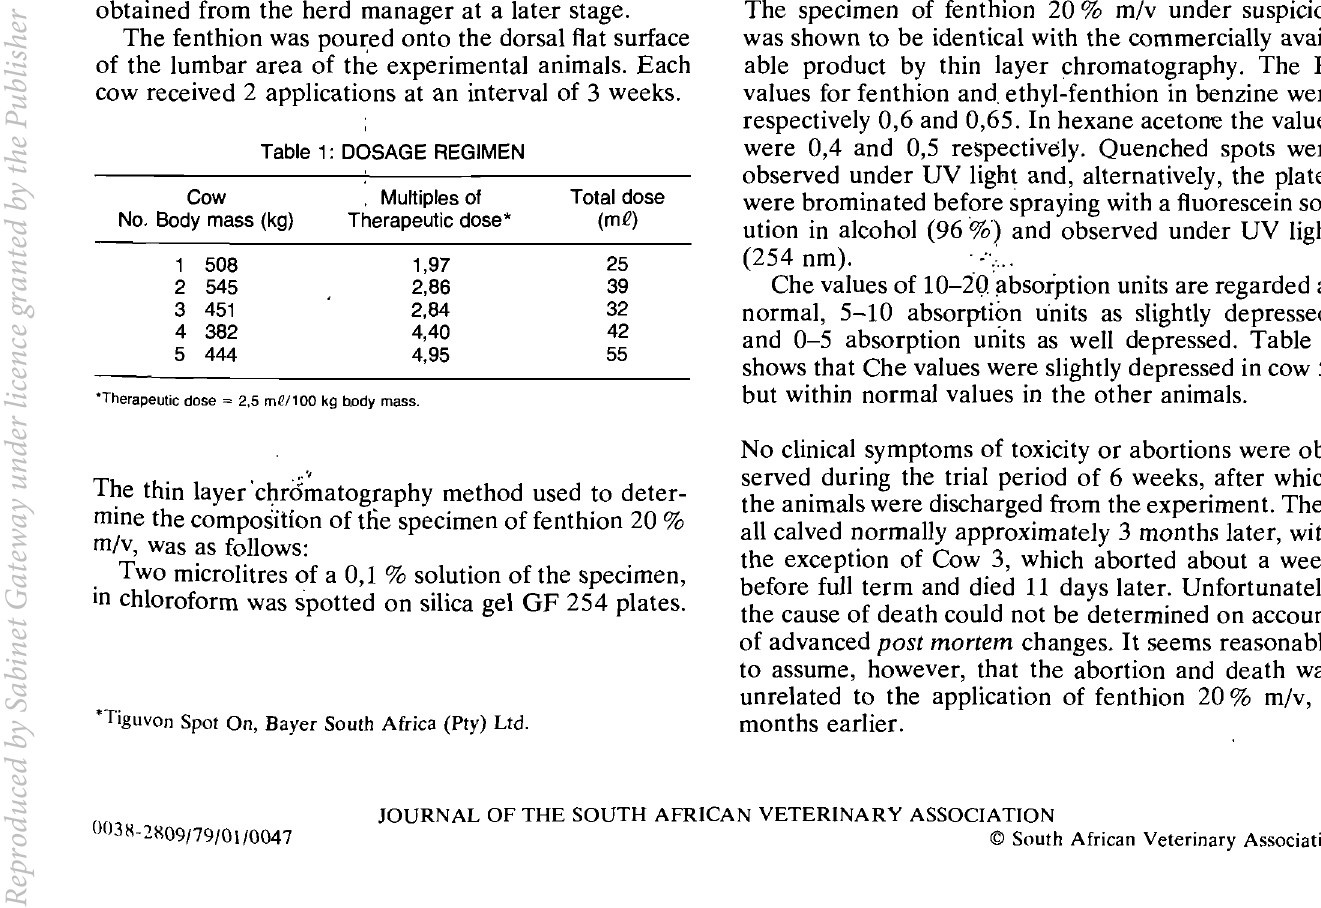
Table 1: DOSAGE REGIMEN Cow No. Body mass